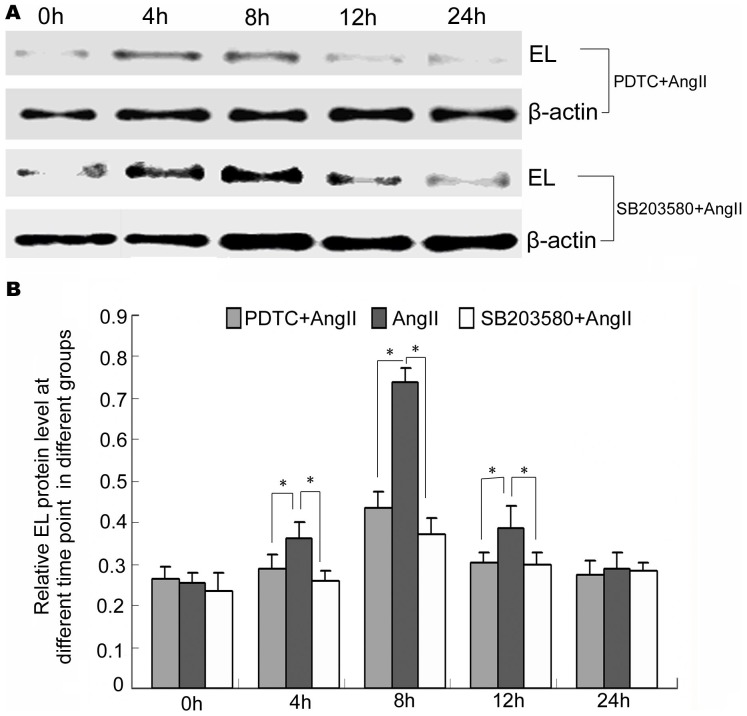
Blockade of NF-κB p65 or MAPK p38 was shown to decrease EL levels in HUVECs by western blotting.(A) EL expression levels in different groups detected by western blotting. (B) Semi-quantitative analysis of the EL levels detected by western blotting. * Indicates statistical significance (p<0.05).